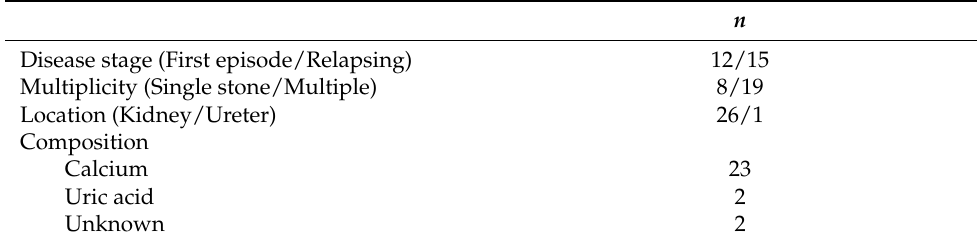
Table 2. Stone characteristics.